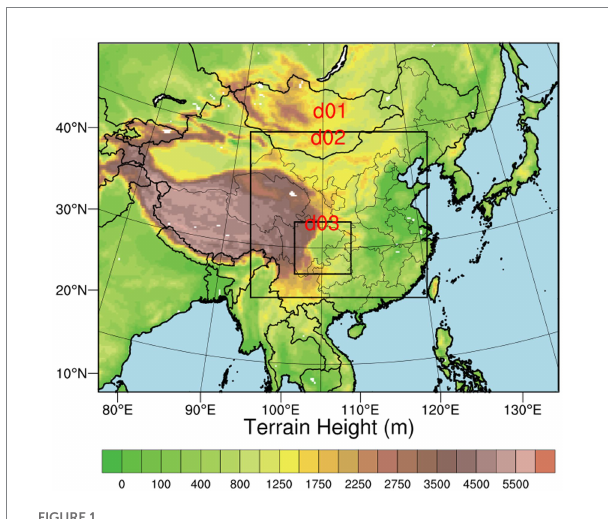
FIGURE 1 Map of three nested WRF-CMAQ model